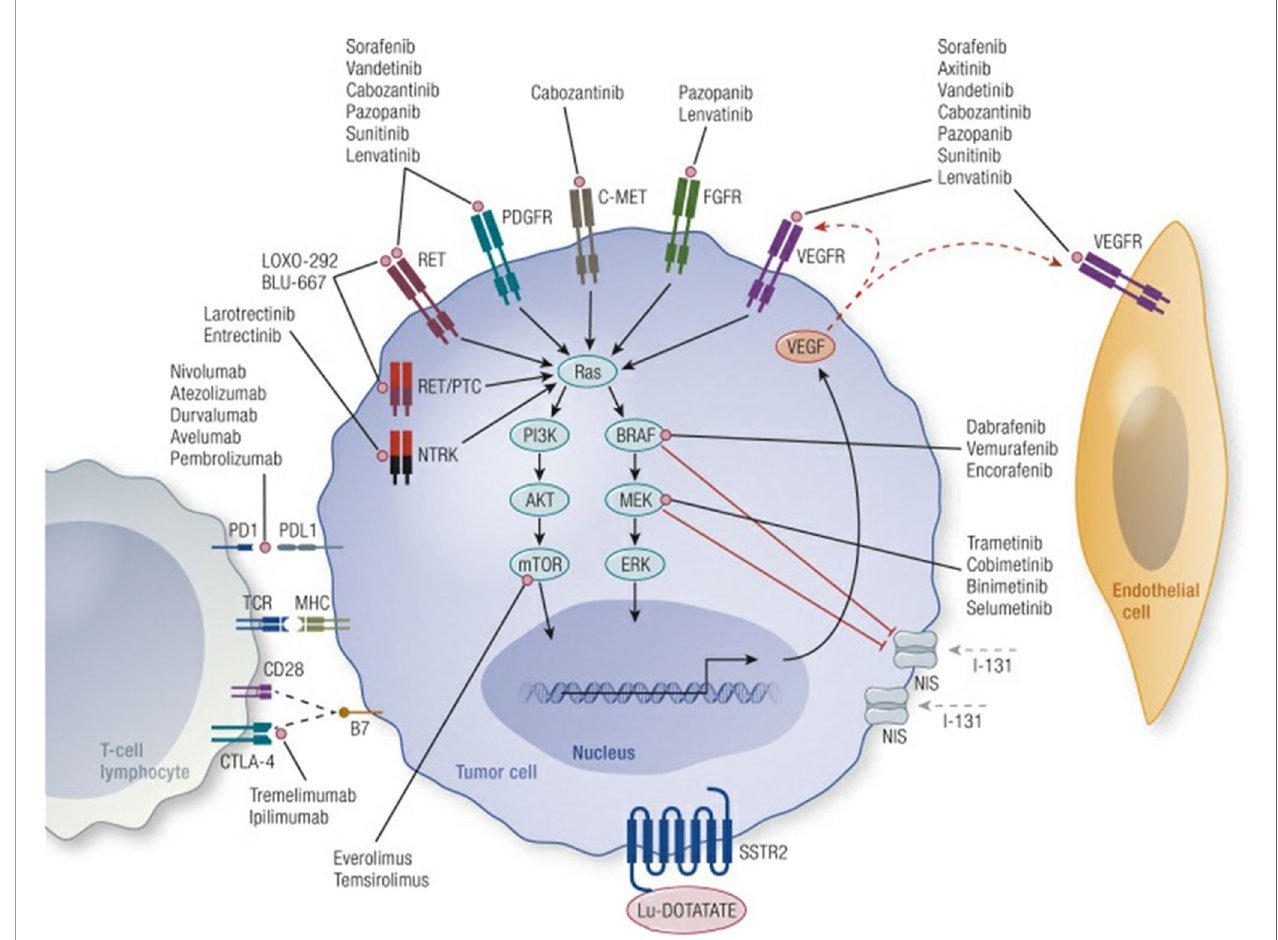
FIGURE 1 | Mechanisms of tumor genesis in thyroid cancer and site of action of novel therapeutic agents. Credit Cabanillas et al., Targeted Therapy for Advanced Thyroid Cancer: Kinase Inhibitors and Beyond, Endocrine Reviews, 2019, 40:6, by permission of Endocrine Society, License# 4956001448885.